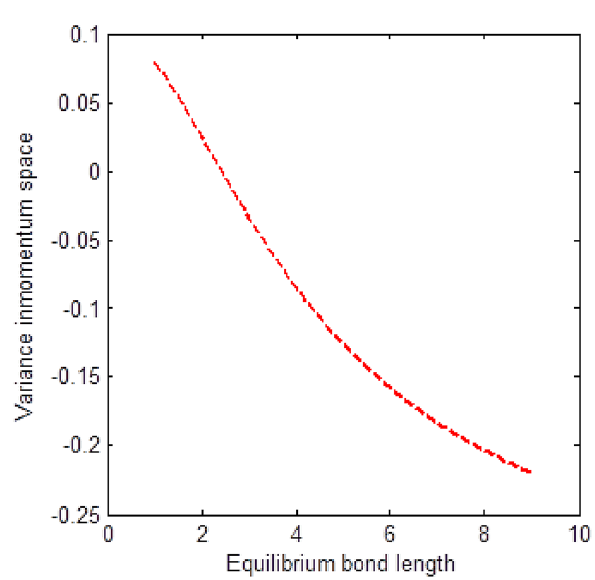
Figure 9. Variance for momentum space against the equilibrium bond length with µ = n = ℓ = (cid:31) = D e = (cid:31) = 1, and C = 0 of the pseudoharmonic-like potential